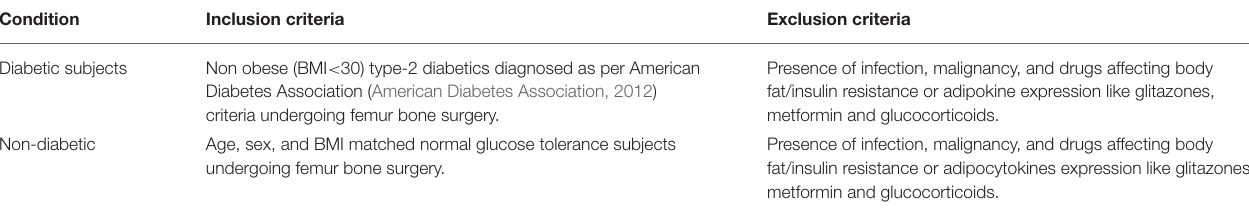
TABLE 1 | Inclusion and exclusion criteria for the study subjects.